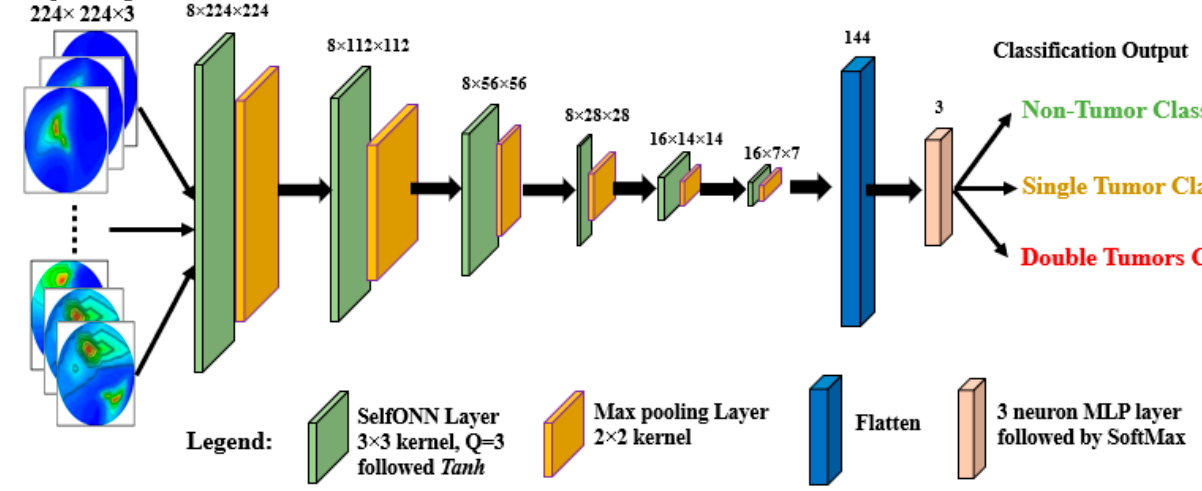
Figure 13. Proposed BrainImageNet using Self-ONN.